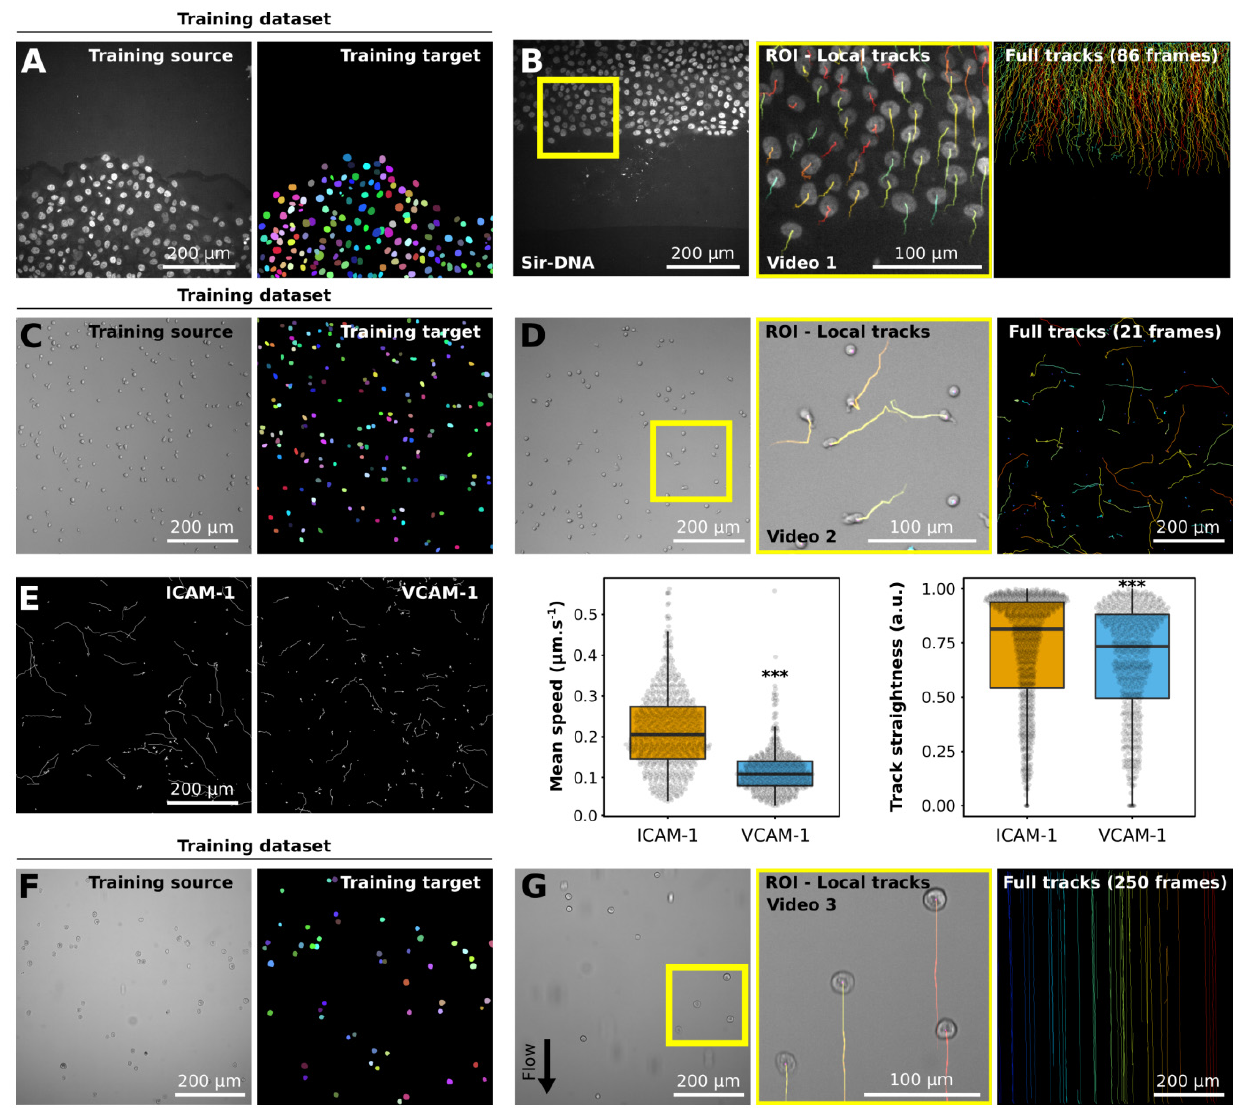
Figure 2. Example of datasets analyzed using StarDist and TrackMate. ( A , B ) Migration of MCF10DCIS.com, labeled with Sir-DNA, recorded using a spinning disk confocal microscope and automatically tracked. Examples of images used to train StarDist ( A ), and an example of results obtained using automated tracking are displayed ( B , Video 1). The yellow square indicates a magnified ROI, where the local track of each nucleus is displayed. The full cell tracks are displayed on the left. Tracks are color-coded as a function of their maximum instantaneous velocity (blue slow, red fast tracks). ( C – E ) Migration of activated T cell plated on VCAM-1 or ICAM-1, recorded using a brightfield microscope and automatically tracked. Examples of images used to train StarDist ( C ) and an example of results obtained using automated tracking are displayed ( D , Video 2). ( E ) Comparison of the migration of activated T cells on VCAM-1 or ICAM-1. Track mean speed and track straightness were quantified. Data are displayed as boxplots. *** p-value = <0.001, p-values were determined using a randomization test. ( F , G ) Cancer cells flowing in a microfluidic chamber, recorded live using a brightfield microscope and automatically tracked (Video 3). Examples of images used to train StarDist ( F ), and an example of results obtained using automated tracking are displayed ( G ). The full tracks shown here were color-coded as a function of their x